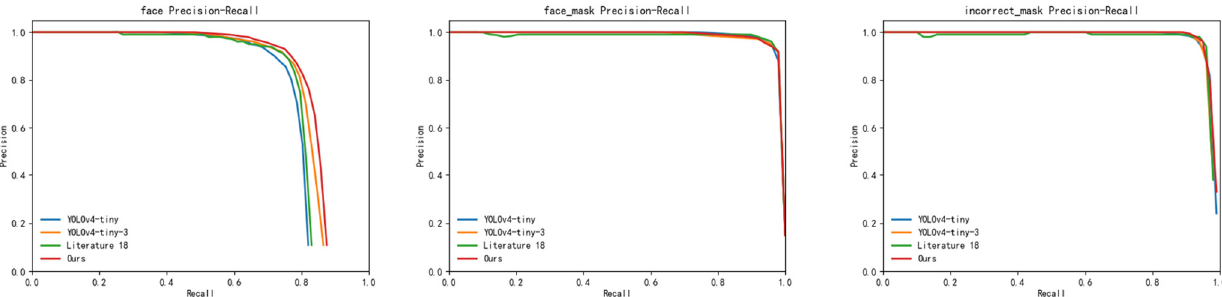
Figure 8. P-R curves for different algorithms with different targets.